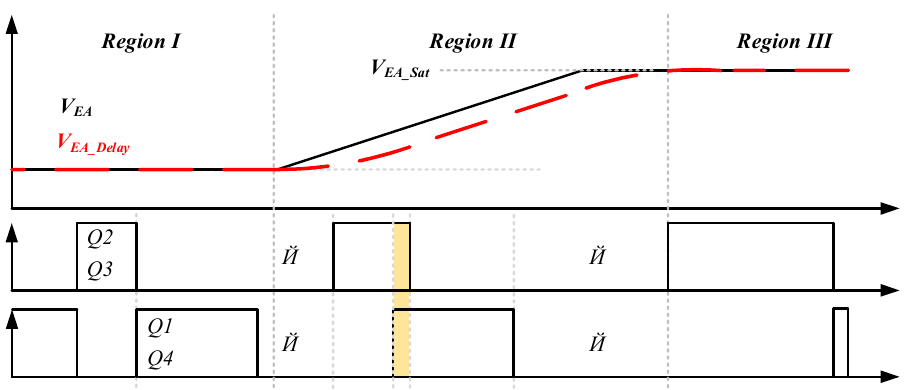
Figure 9. PWM signal of the RC delay controller in the V EA steady-, transient, and saturation states. Given the lack of RC delay control, this study proposes a boundary limit control method suitable for stacked buck converters. Apart from accelerating the transient re- sponse, the boundary limit control method is not limited by the saturation of the compen- sator. Figure 10 shows a schematic of the boundary limit control method. The control prin- ciple aims to set the upper and lower limits of V EA , and the limit value is fixed at the steady- state V EA and take a settable boundary to generate a feedback compensation output V EA_Limit .